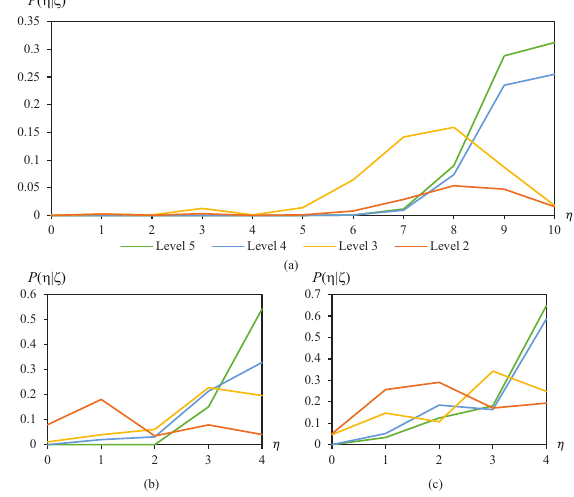
Figure 3. The probability function P ( h | z ) for four pilots of different competency